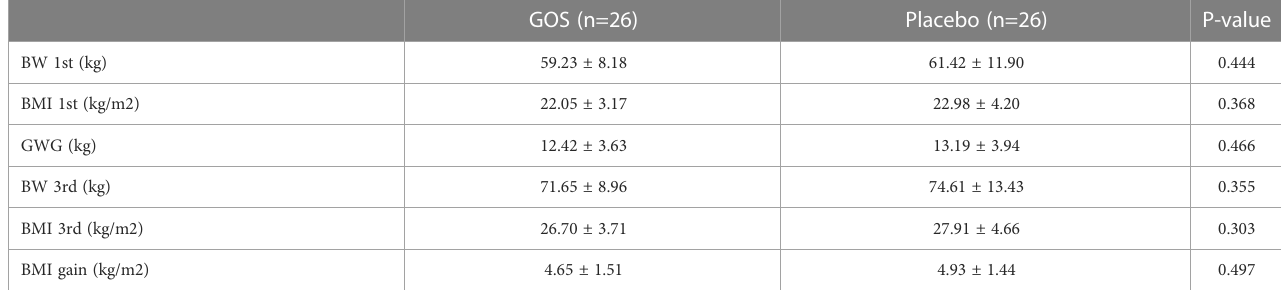
TABLE 3 Changes in weight and BMI during pregnancy.